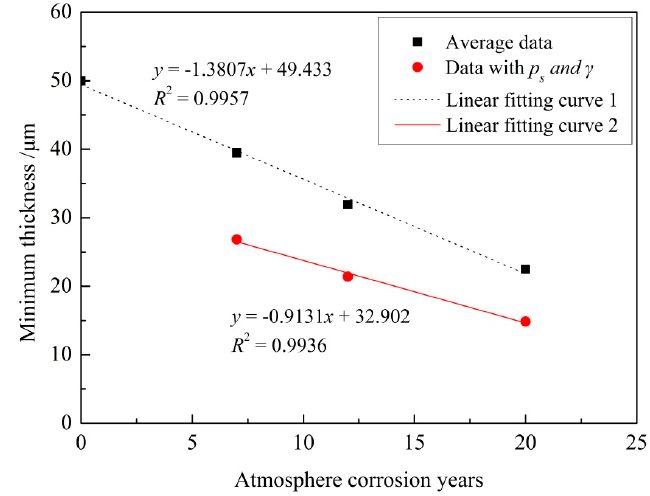
Figure 7. Relationship between atmospheric corrosion exposure years and remaining thickness (20 years’ data from coating-still-existing